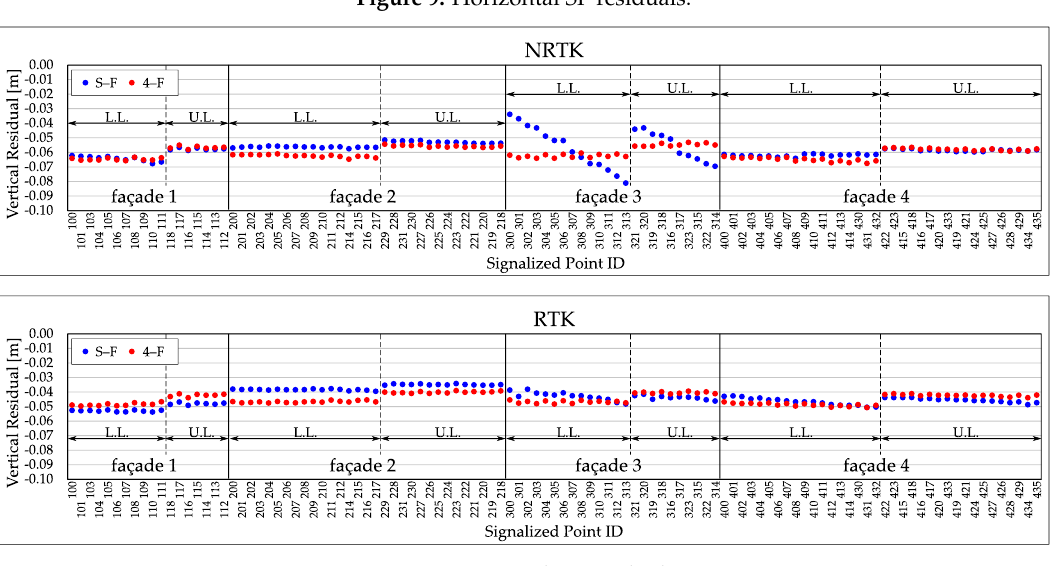
Figure 10. Vertical SP residuals.